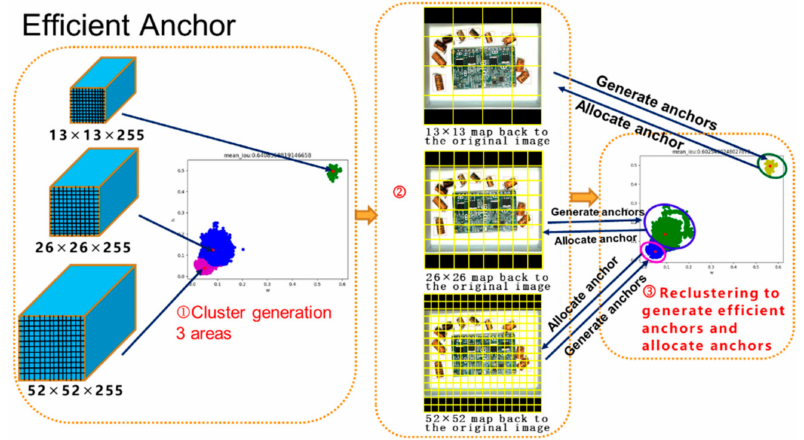
Figure 6. Generation and allocation of efficient